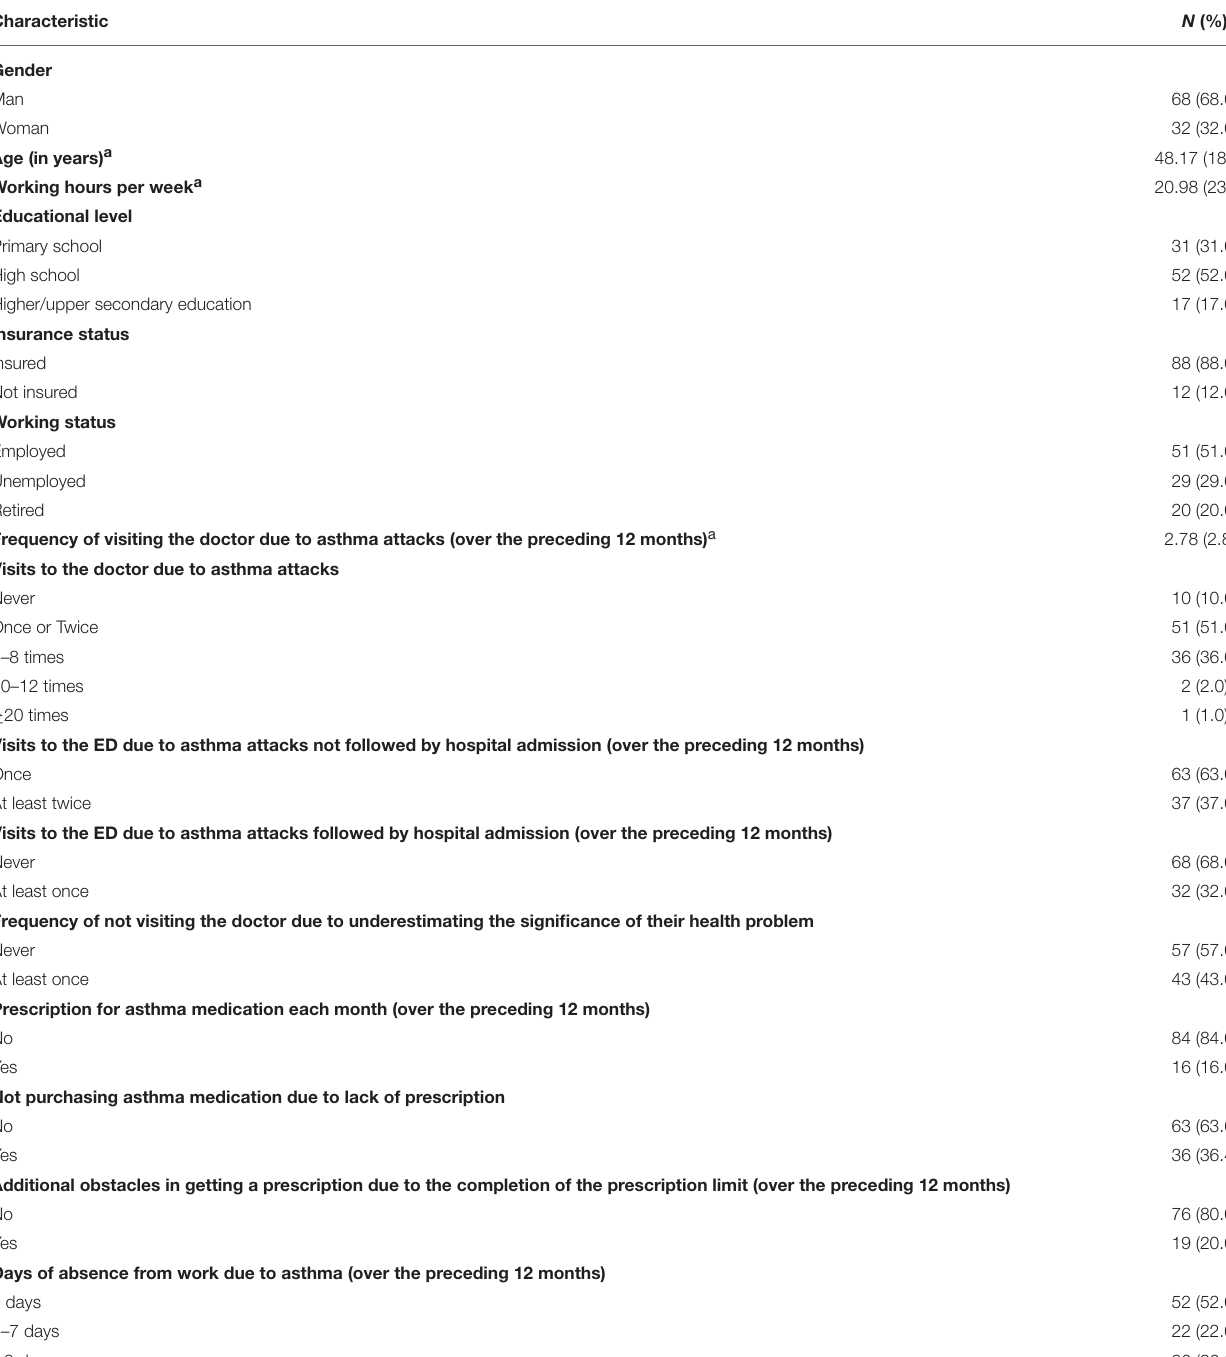
TABLE 1 | Sample characteristics (demographics, use of health services, use of medication and absenteeism from work/loss of productivity).